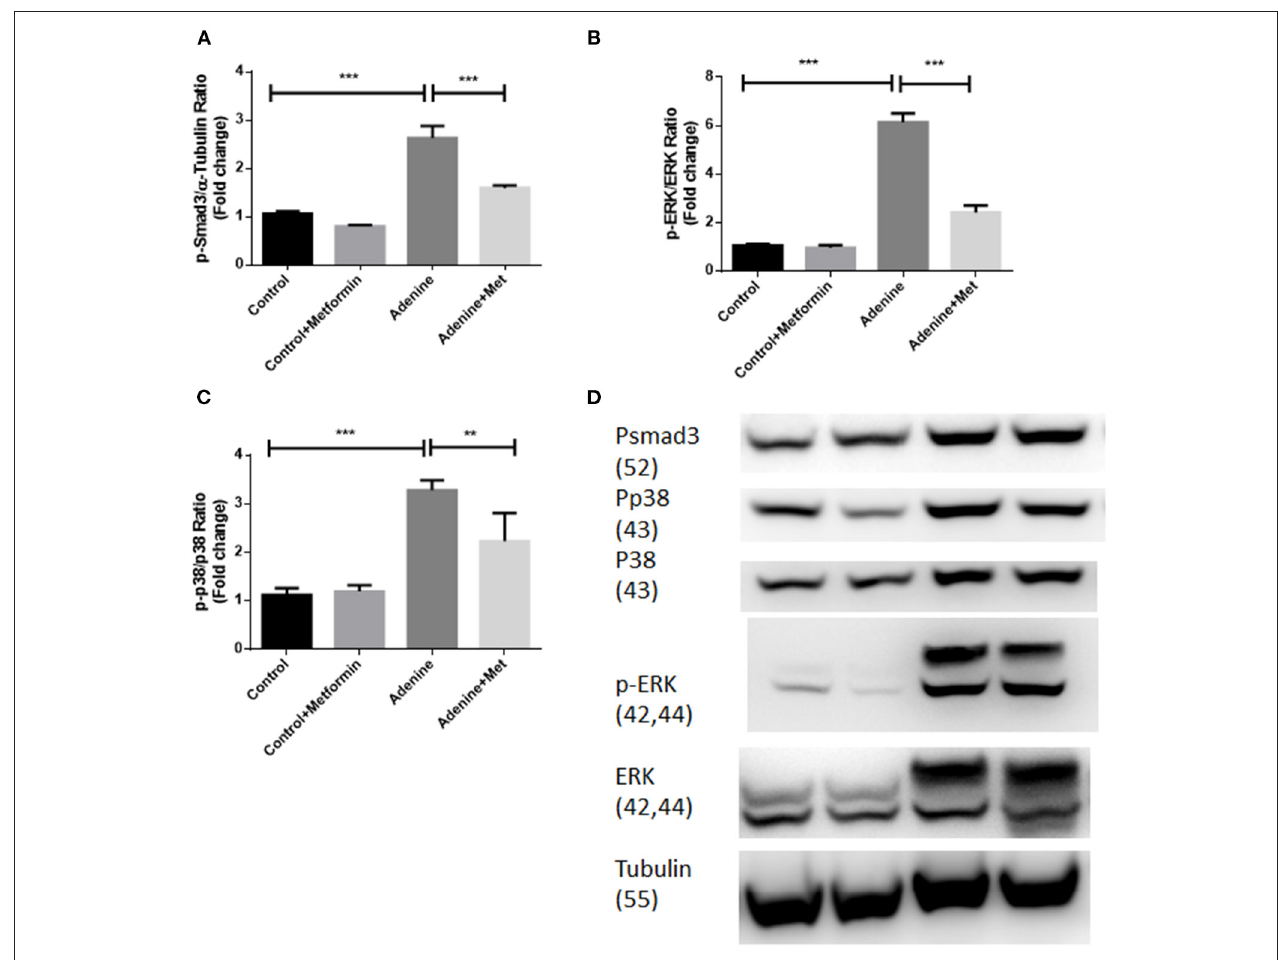
FIGURE 5 | Metformin suppresses TGF- β 1 signaling pathways through inhibiting activation of Smad3, ERK1/2, and p38 in a mouse model of adenine-induced renal injury. Western blot results demonstrated that metformin suppressed adenine induced phosphorylation of p-Smad3 (A,D) , p-ERK1/2 (B,D) , and p-P38 expression (C,D) in adenine treated mice. Data are expressed as mean ± SEM. ** P < 0.01, *** P < 0.001, n = 8.